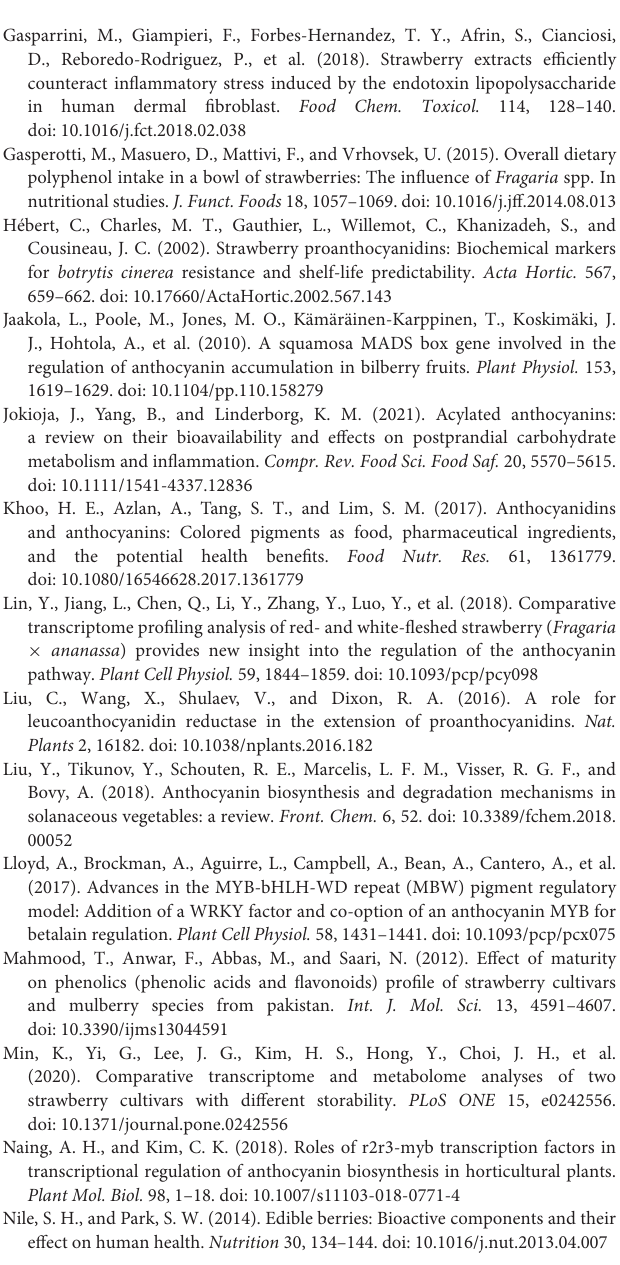
Supplementary Table S7 | All primers used for qPCR validation in this